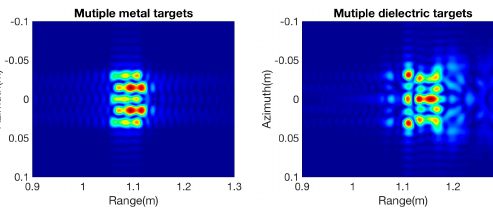
Figure 9. Image of a cluster of three by three metal spheres ( left ) and dielectric spheres ( right ).